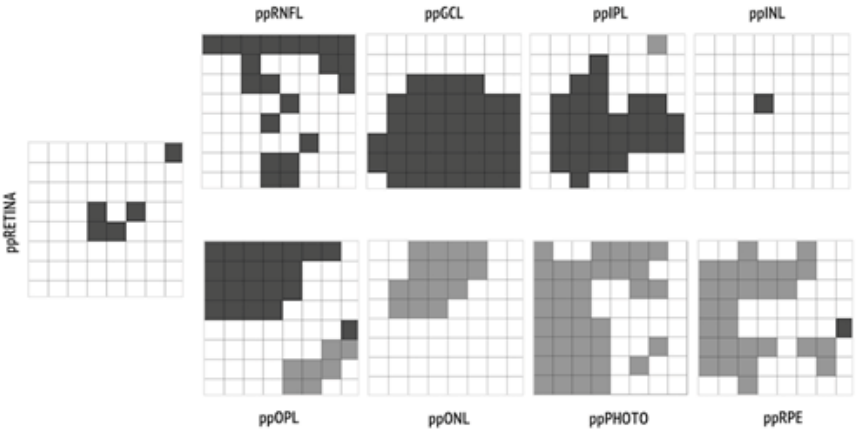
Figure 3. Regions of interests characterized by statistically significant ( p < 0.05) thinning in MS eyes versus control eyes are represented in dark grey; regions characterized by statistically significant ( p < 0.05) thickening are represented in light grey. Table 3. Peripapillary RNFL thickness values provided by RNFL-N axonal analytics and statistical differences in autosomal dominant optic atrophy (ADOA) and control subjects.